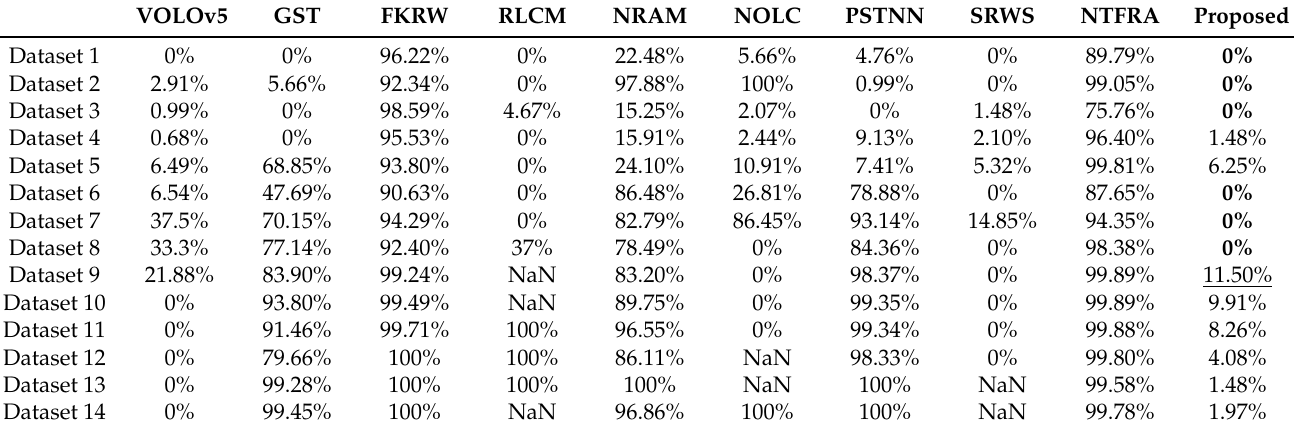
Table 6. Comparison of average FAR between the proposed method and 9 baseline methods in 14 sequence